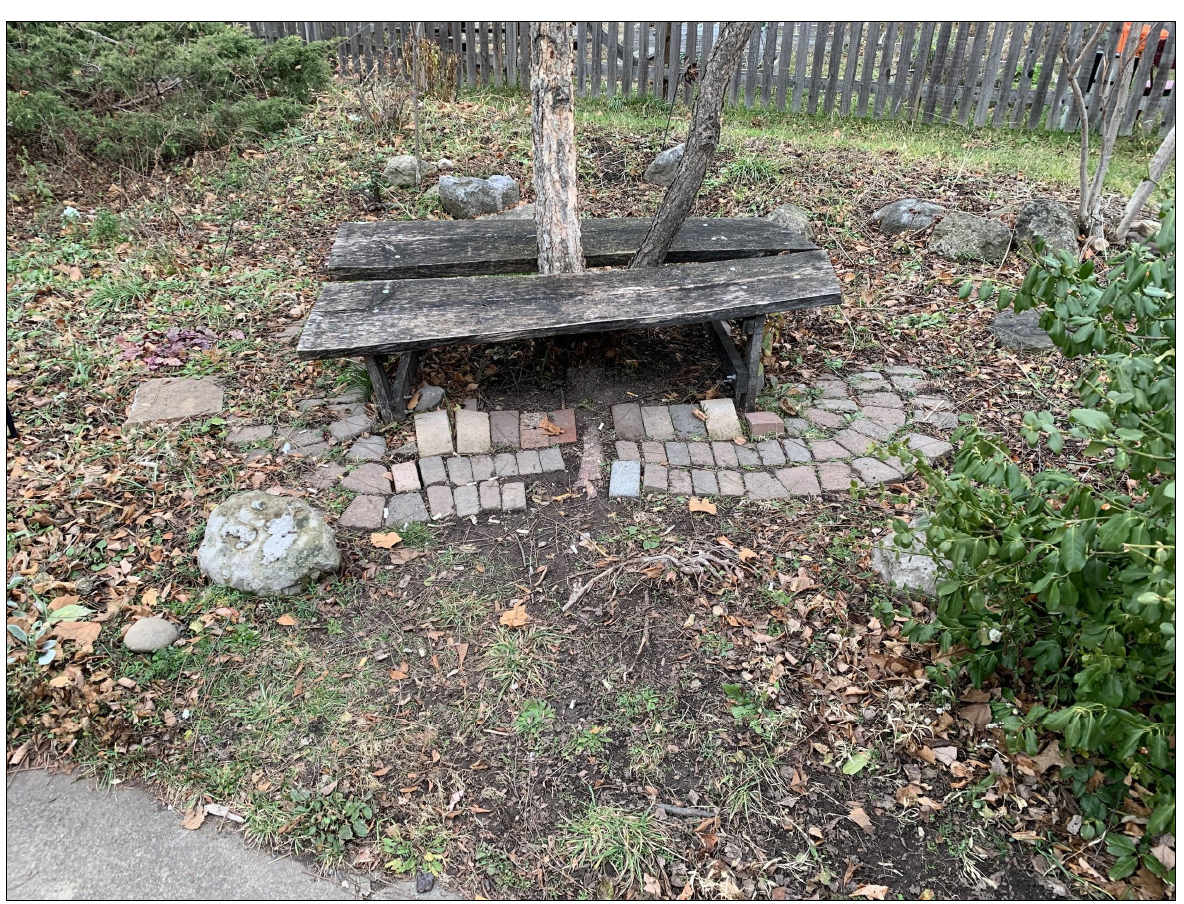
Figure 2. The finished bench in